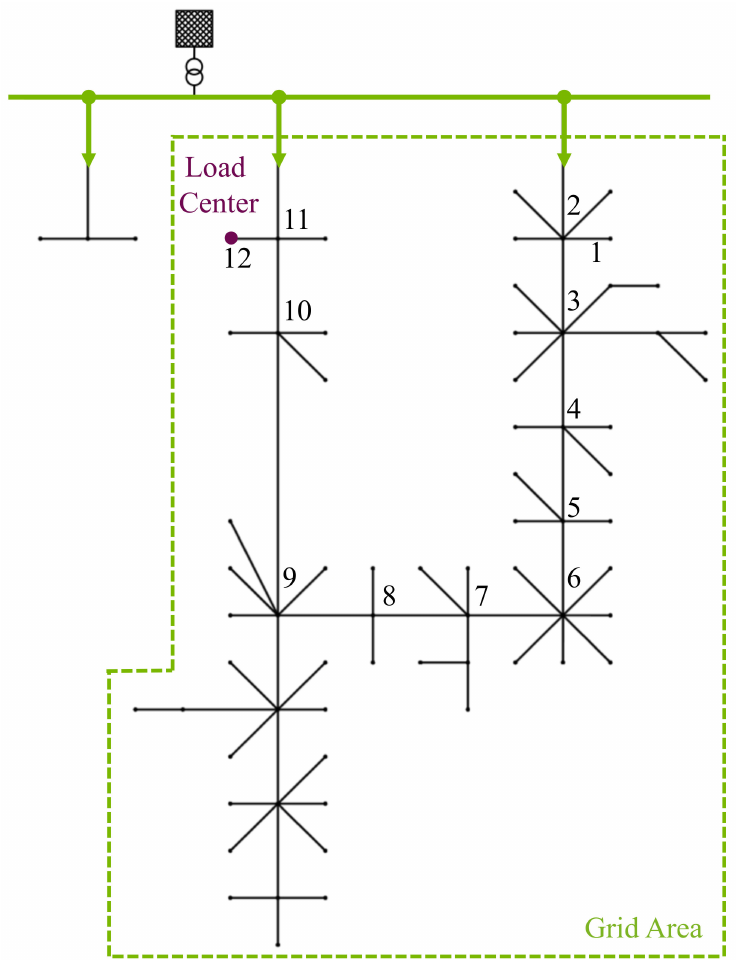
Figure 7. A low voltage grid with sensors at the